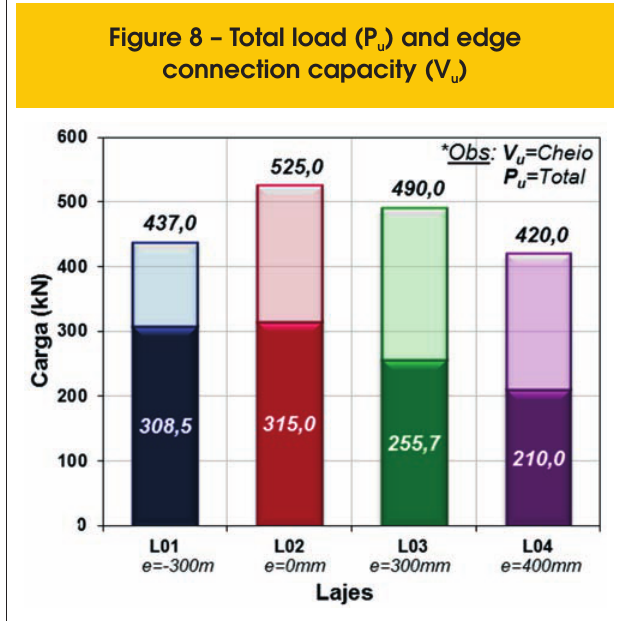
Figure 8 – Total load (P ) and edge u connection capacity (V )